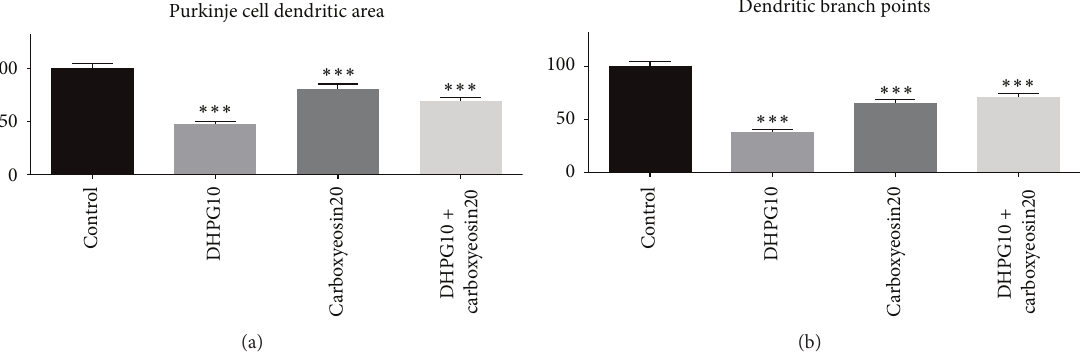
Figure 4: (a) Size of Purkinje cell dendritic arbors with different pharmacological treatments: The mean size of control Purkinje cells was considered as 100%. Dendritic tree size was reduced to 48% of control with DHPG treatment. Cotreatment with carboxyeosin resulted in a rescue of the dendritic area to 70% of the control value, similar to the size after treatment with carboxyeosin alone. These differences were significant with 𝑃 < 0.001 ( ∗∗∗ ). Error bars represent the SEM. (b) Number of branch points with the pharmacological treatments: The mean number of branch points of control Purkinje cells was considered as 100%. The branchpoint number is reduced to 37% in DHPG treated cultures compared to control. Cotreatment with carboxyeosin showed a rescue of the branch points to 70% of the control value. These differences were significant with 𝑃 < 0.001 ( ∗∗∗ ). Error bars represent the